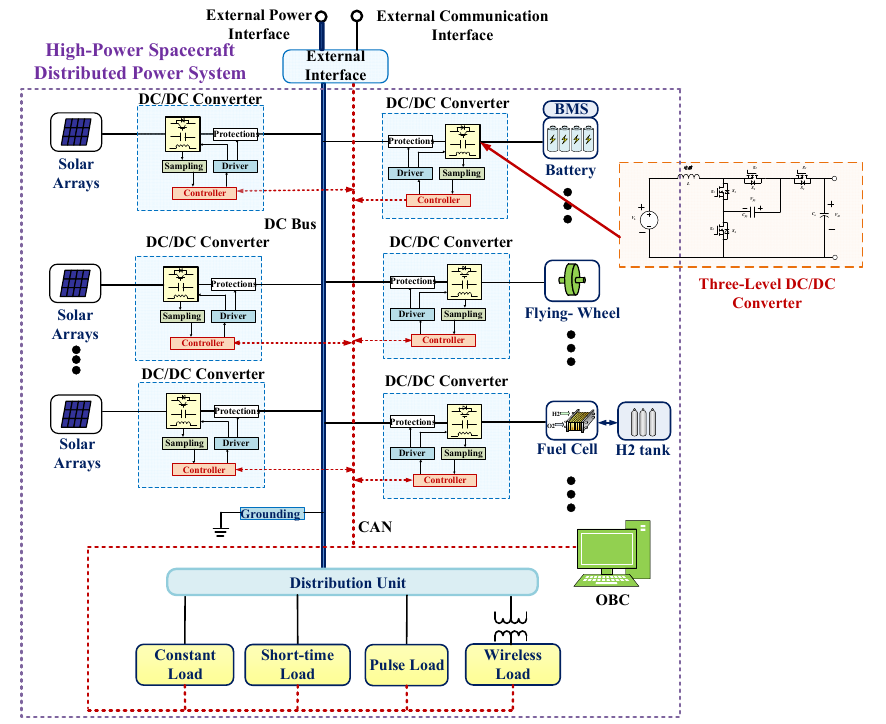
Figure 1. Typical high-power spacecraft distributed power system with DC/DC converters.